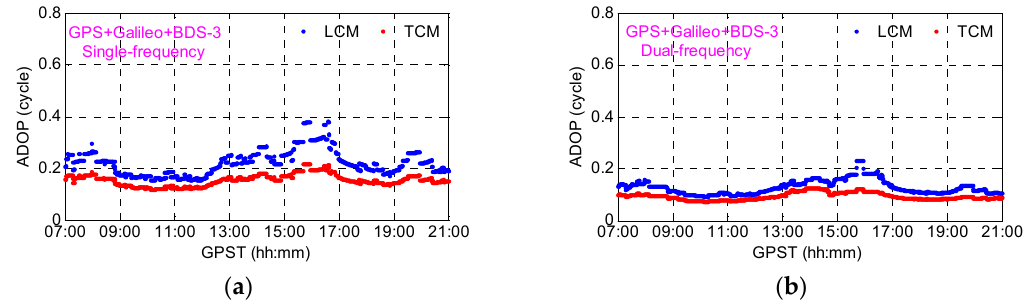
Figure 11. ADOP for GPS/Galileo/BDS-3 single-frequency ( a ) and dual-frequency ( b ) solutions with 10 ◦ elevation cut-o ff angle.